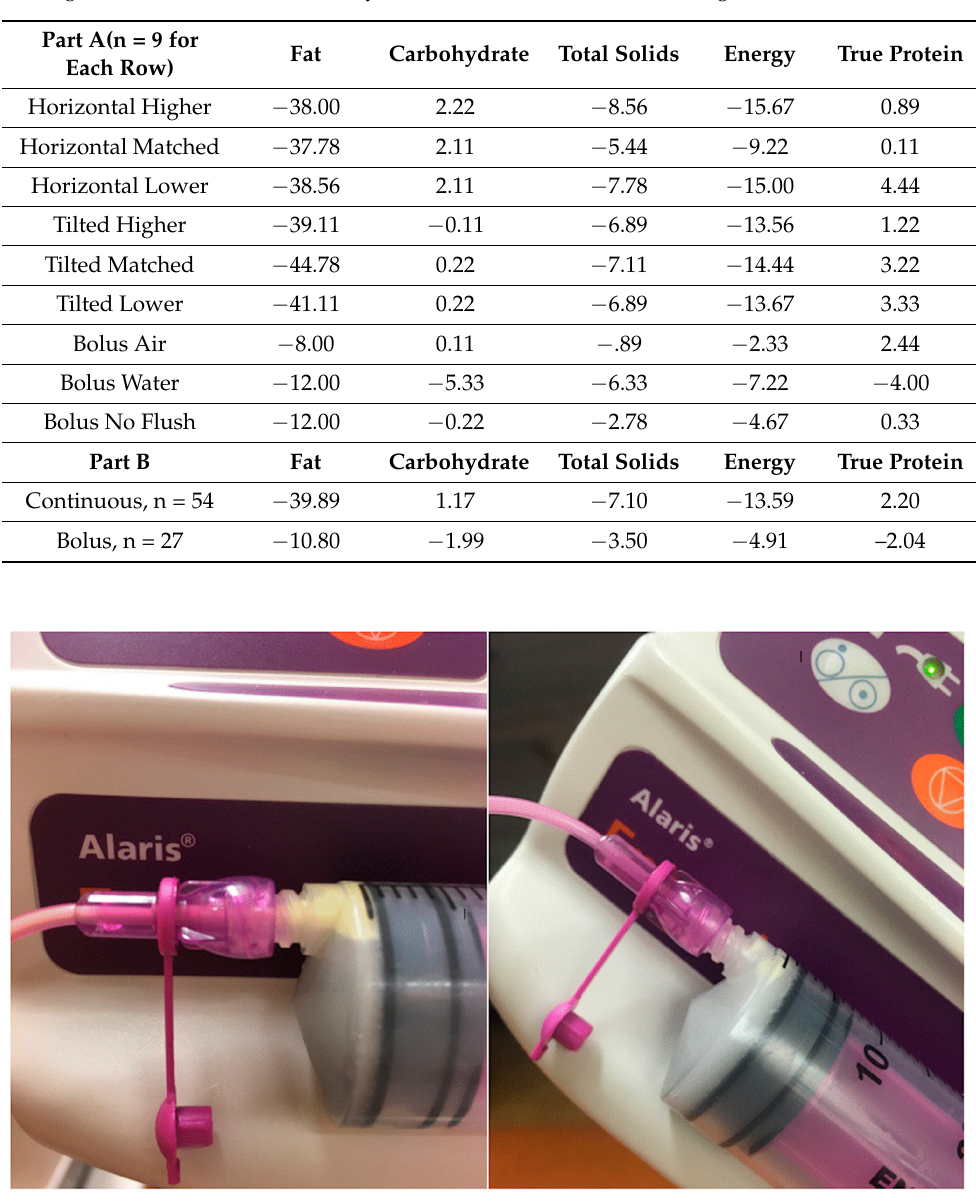
Table 2. Mean percentage (%) difference of mean mass concentration of macronutrients. Part A: After feeding simulations; Part B: Summary after continuous and bolus feeding simulations.